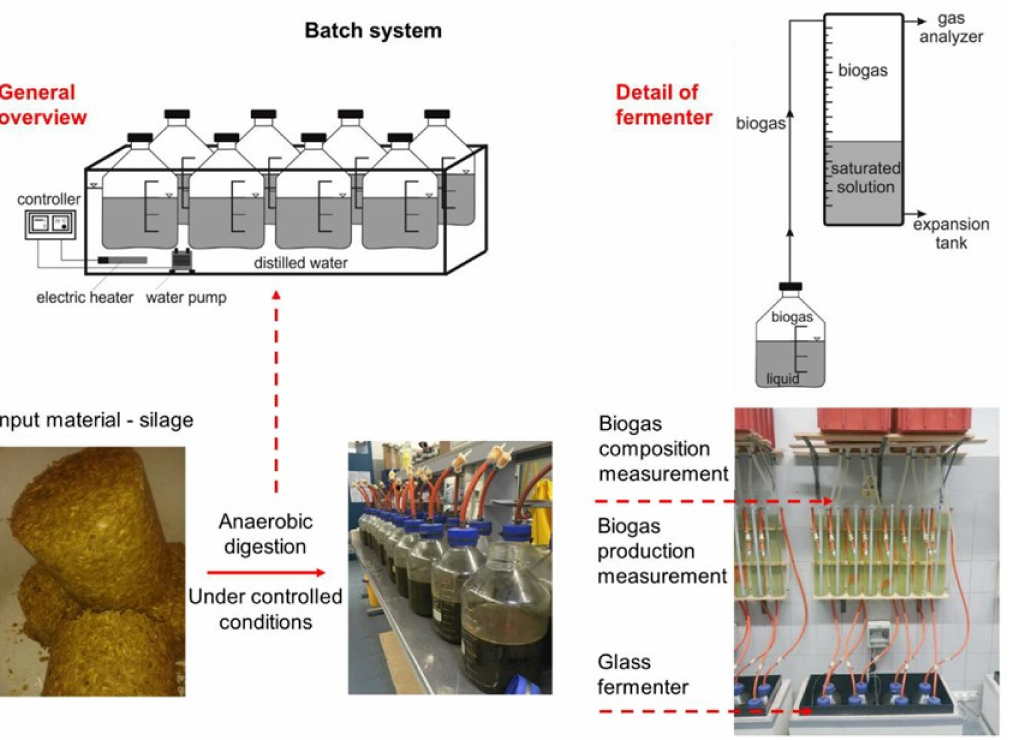
Figure 2. Diagram of laboratory batch fermenters. Adapted with permission from